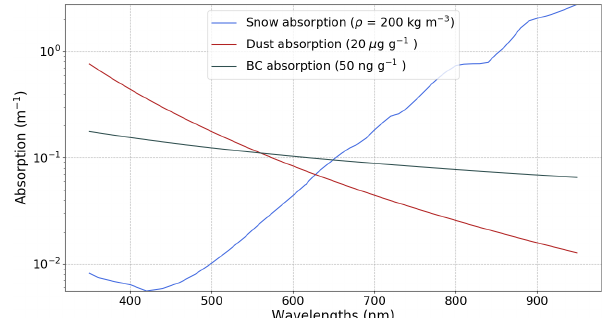
Figure 2. Spectral signature of the absorption coefficients σ a for snow and different types of LAPs assuming a snow density of 200kgm − 3